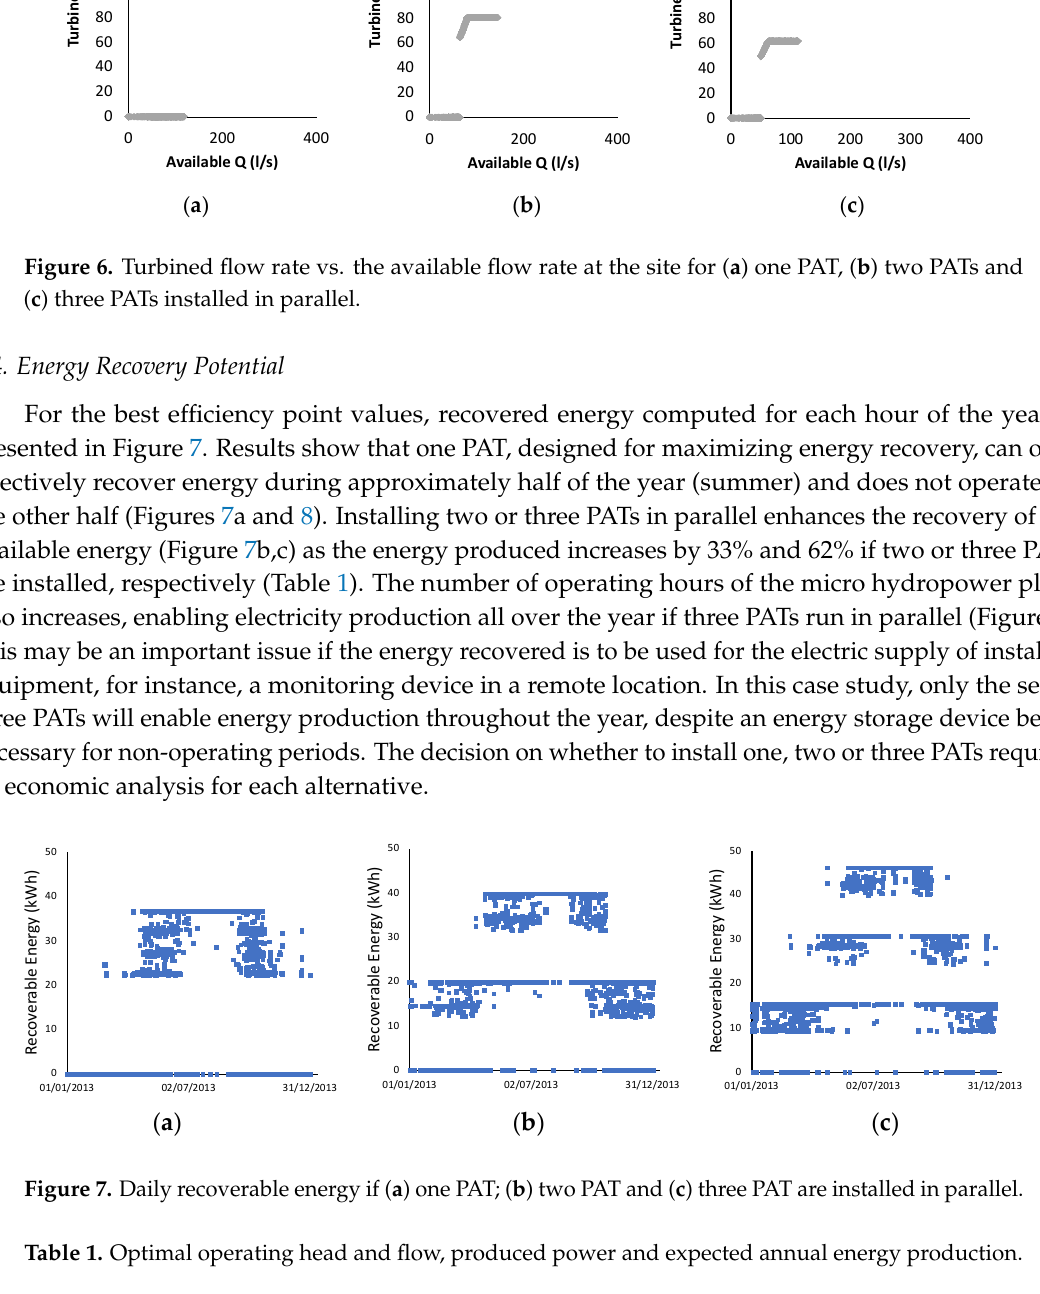
(*) In the preliminary assessment these values refer to annual average.